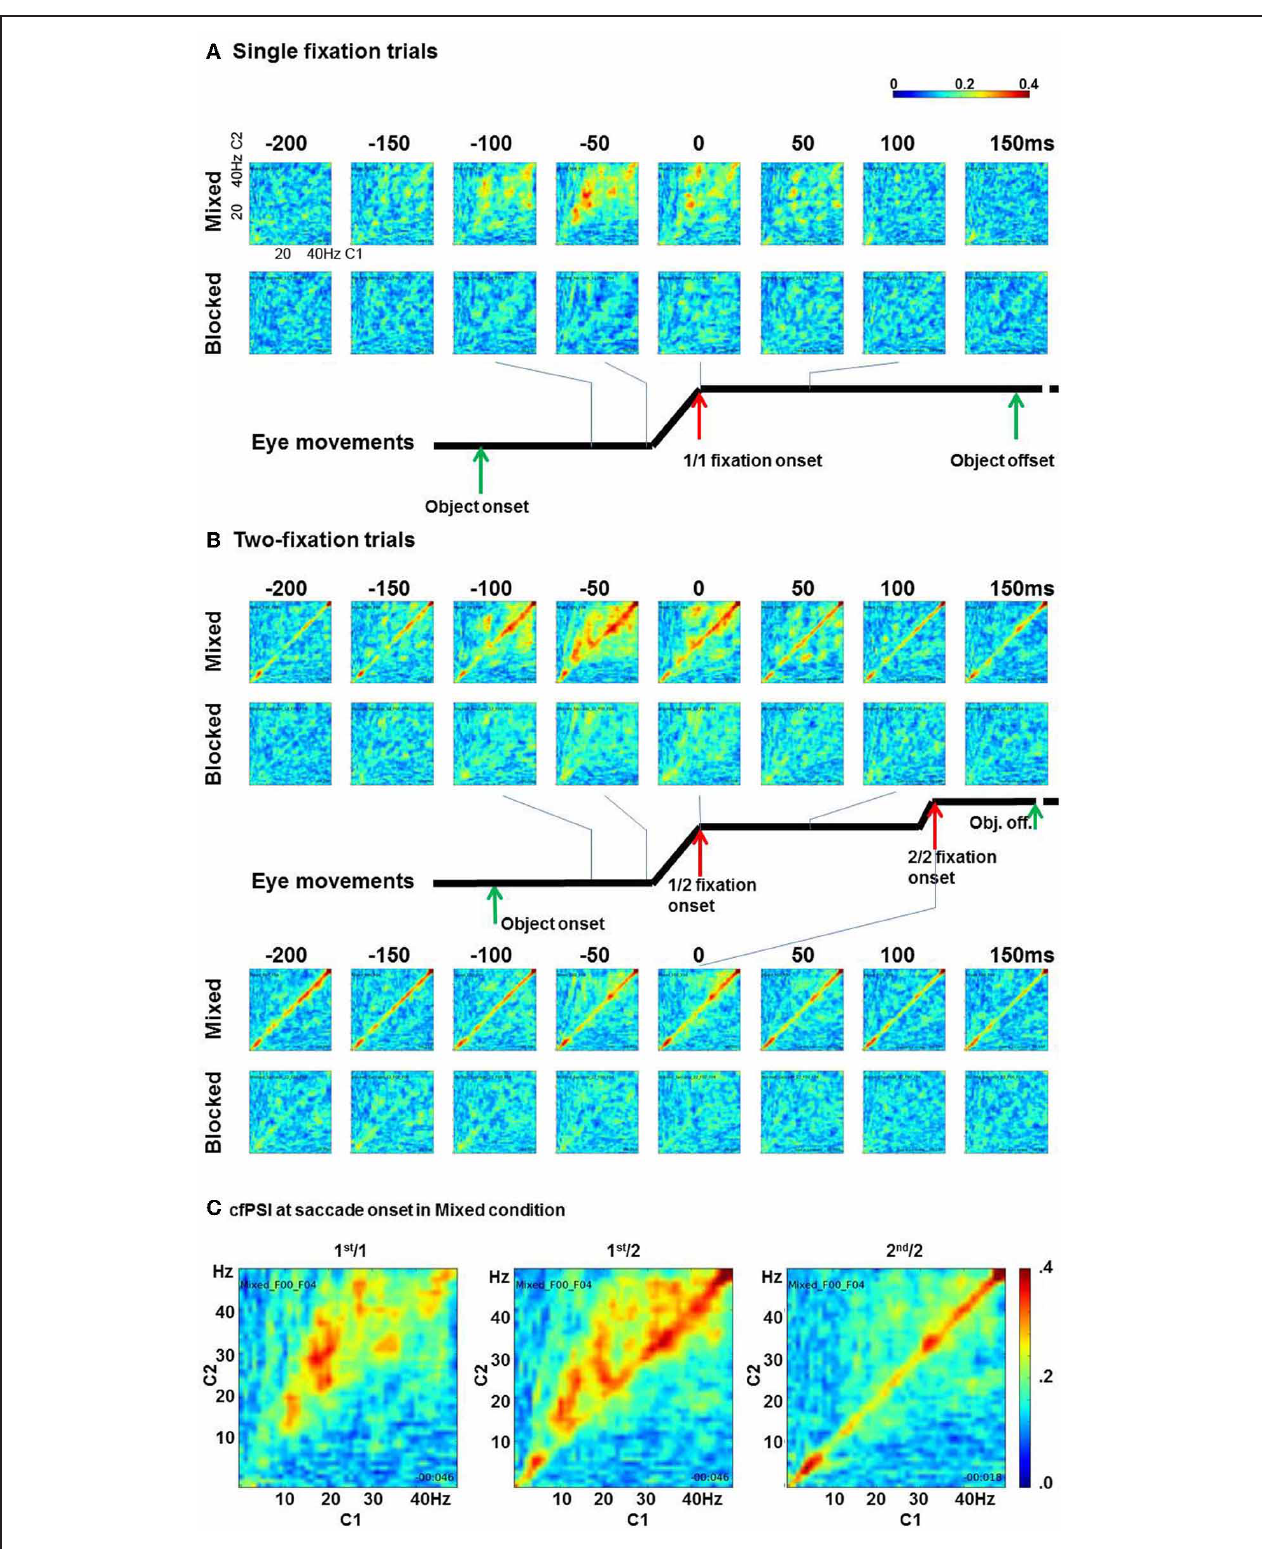
FIGURE 3 | Cross-frequency phase synchronybetween C1 and C2. (A) The cfPSI in the single-fixation trials in the mixed and blocked conditions. The x and y axes in each matrix indicate C1 and C2 frequencies. (B) The cfPSI in the two-fixation trials, and (C) The cfPSI at the onset of the 1st/1, 1st/2, and 2nd/2 saccades.